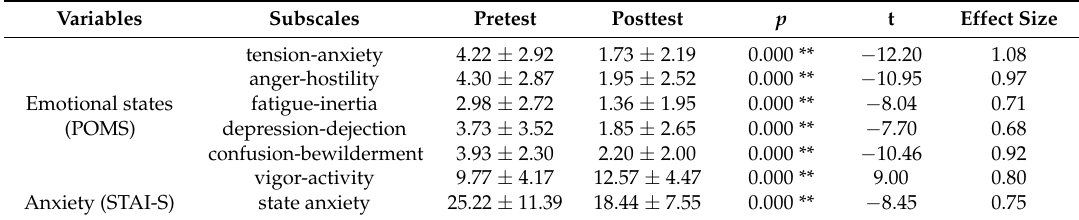
Table 3. Effect of forest bathing on emotional state and anxiety.